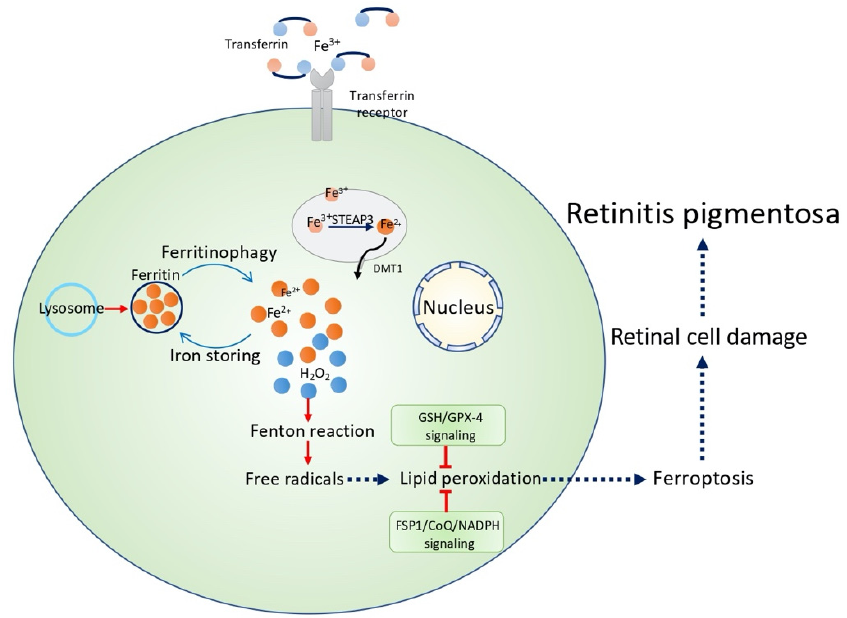
Figure 1. A schematic figure showing ferroptosis as the potential mechanism for retinitis pigmentosa through GSH/GPx-4 signaling or FSP1/CoQ/NADPH signaling.